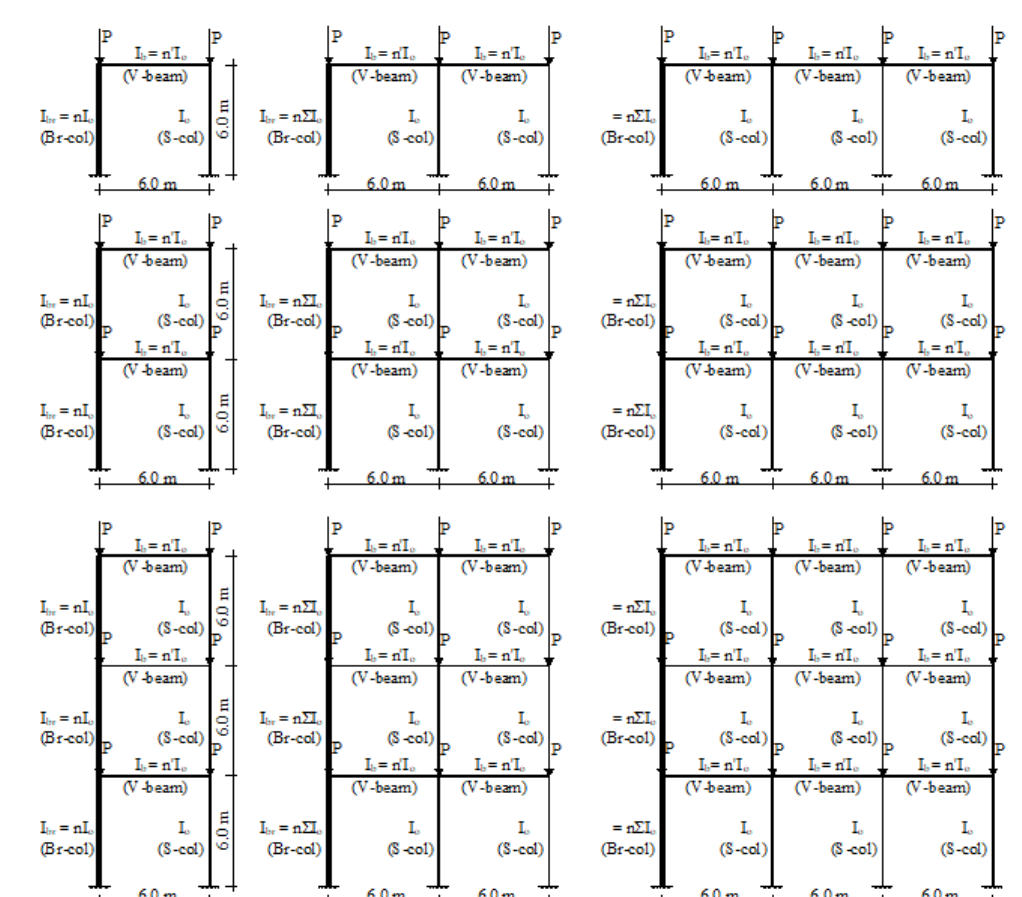
Figure 3. Multi-stories, multi-bays frame